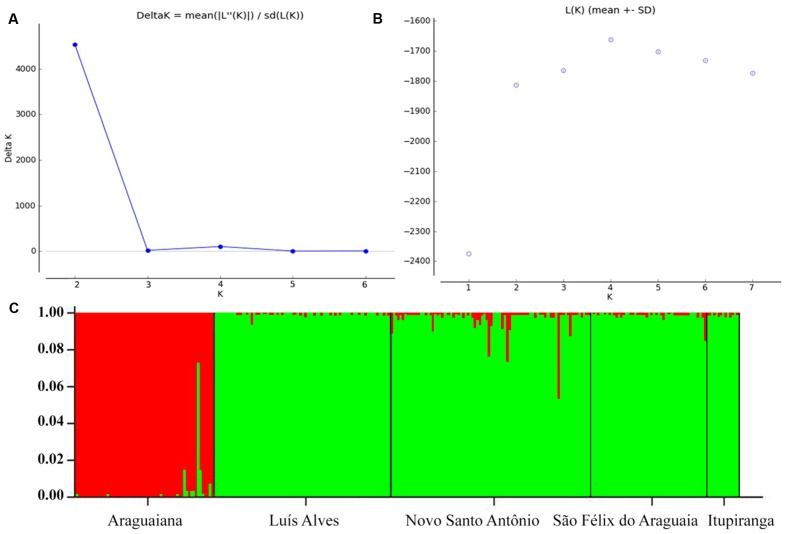
Genetic structuring of Arapaima gigas from the Araguaia-Tocantins basin, according to Bayesian analysis. Estimating the number of K groups based on (A) ΔK and (B) the mean maximum likelihood. (C) Each column represents a different individual and the colors represent genetic stocks. The collection sites are separated by black lines.